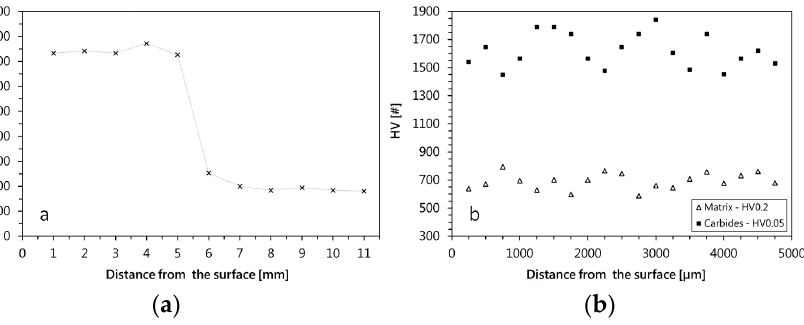
Figure 7. Vickers hardness measurements on the T cross-section: ( a ) hardness profile across the hardfacing plate from the resistant side up to the steel substrate; ( b ) microhardness values across the hardfacing for matrix and Cr-based carbides.